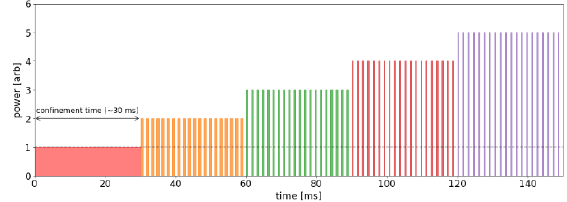
Fig. 1. Example of desirable modulation capability